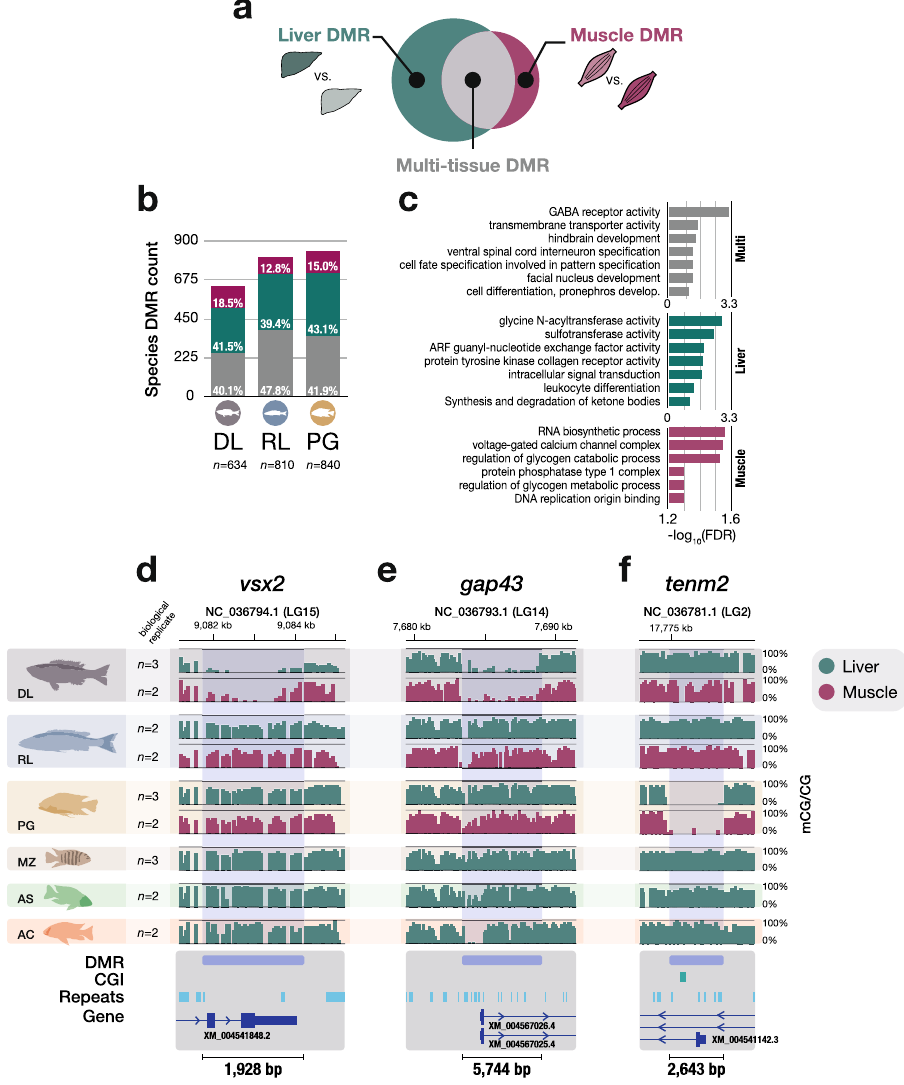
Fig. 4 Multi-tissue methylome divergence in Lake Malawi cichlids is associated with early development/embryogenesis. a Distinct species-speci fi c methylome patterns in Lake Malawi cichlids can be found in liver or muscle tissues, or in both tissues ( ‘ multi-tissue ’ ). b Histograms showing the total counts of ‘ species ’ DMRs that are either liver-, muscle-speci fi c or present in both (multi). Only ‘ species ’ DMRs showing distinct DNA methylation patterns in one species are shown. c GO enrichment plots for each DMR class. Only GO terms with Benjamini − Hochberg FDR-corrected p -values < 0.05 are shown. d − f Examples of ‘ species ’ multi-tissue DMRs in genes related to embryonic and developmental processes. Namely, in the genes coding for visual system homeobox 2 vsx2 (LOC101486458), growth-associated protein 43 gap43 (LOC101472990) and teneurin transmembrane protein 2 tenm2 (LOC101470261). Liver and muscle methylome pro fi les shown in green and purple, respectively (averaged mCG/CG levels [%] in 50 bp bins for ≥ 2 samples per tissue per species; scale indicated below each